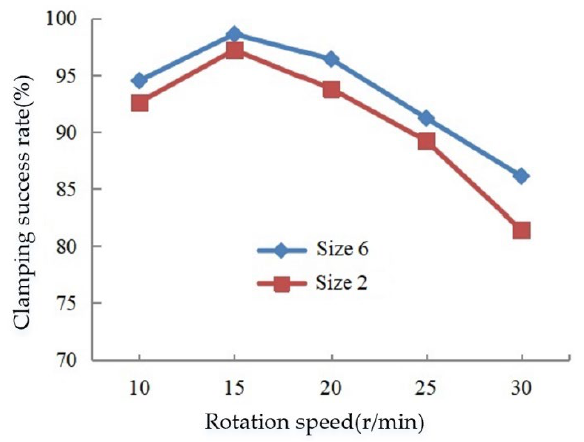
Figure 23. Relationship between clamping success rate and rotation speed.